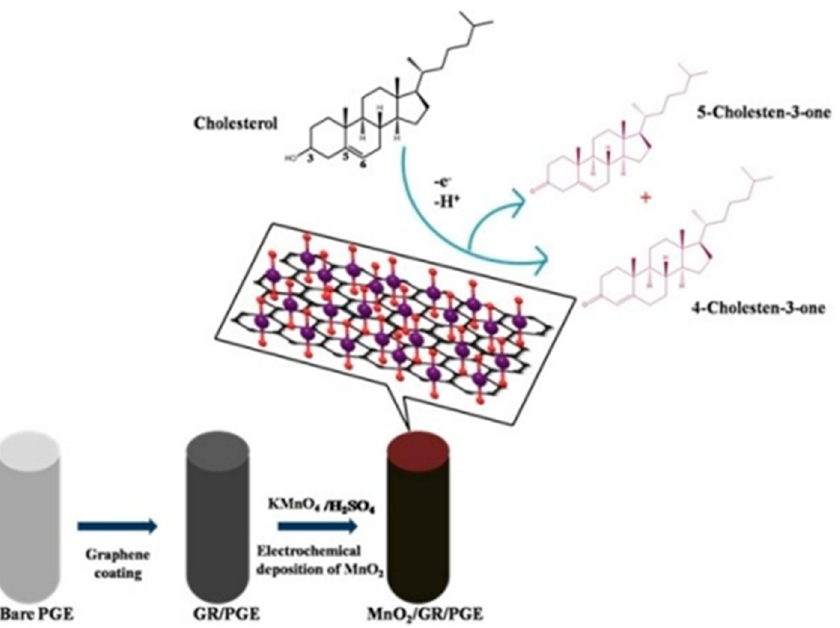
Figure 10. Schematic demonstration of the oxidation of cholesterol at MnO 2 /GR/PG. Reprinted with permission from Ref. [77].